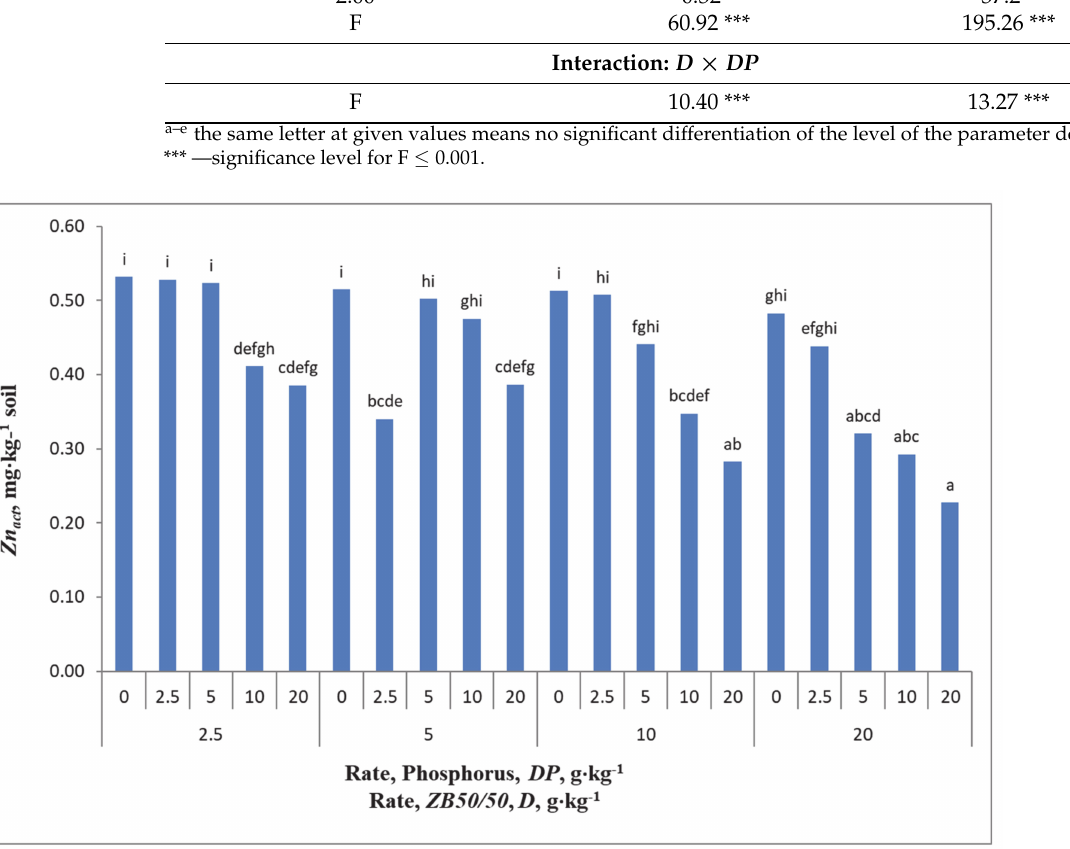
Figure 4. Content of the active zinc fraction ( Zn act ) on the background of interactions ZB50/50 ( D ) and phosphorus ( DP ) rates. Small letters a to l refer to statistical differences among the tested treatments, the same letter means no significant differentiation. Table 8. Regression models elaborated for active Zn ( Zn act ) fractions in treatments with